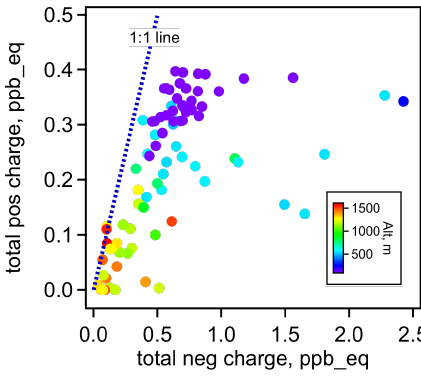
Figure 8. Comparison of the observed and calculated conductivities Figure 7. Charge balance of aerosol components determined using of the liquefied aerosol samples collected by the PILS on the 28 Oct the PILS-IC on 28 October 2008. The units are in parts-per-billion 2008 (ppb) multiplied by charge equivalents. Positive ions were domi- nated by Na + and NH + ; negative by Cl − , NO − , and SO 2 − . 4 3 4